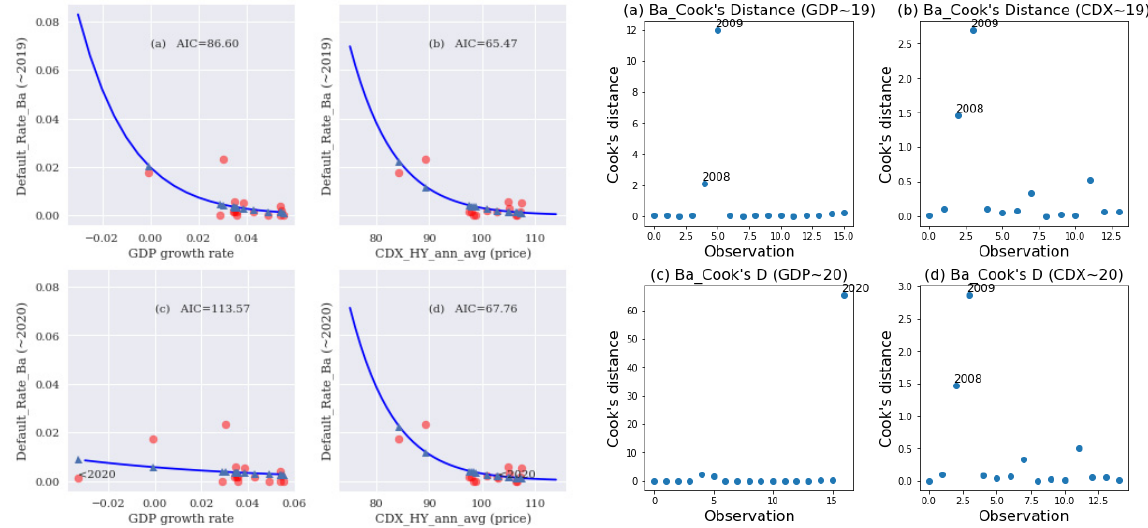
Figure 8. Fitted logistic regression models ( left panel ) and Cook’s distances ( right panel ) of default rate in relation to ( a ) GDP in 2006–2019 data; ( b ) CDX.NA.HY in 2006–2019 data; ( c ) GDP in 2006–2020 data; and ( d ) CDX.NA.HY in 2006–2020 data (price) for Ba class ratings.